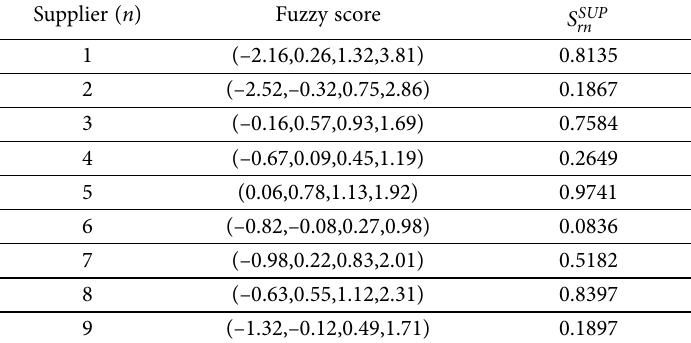
Table 6. The greenness score of suppliers